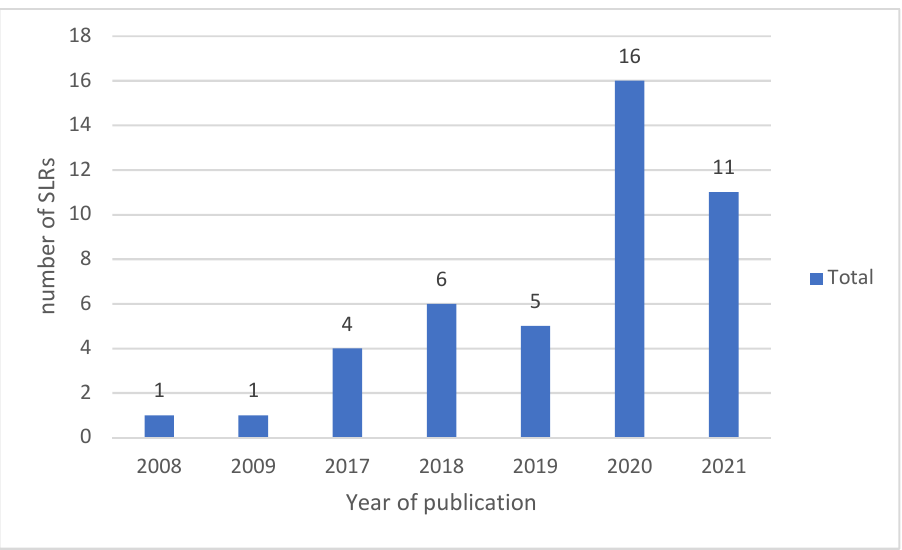
Figure 3. Total number of SLRs per year.